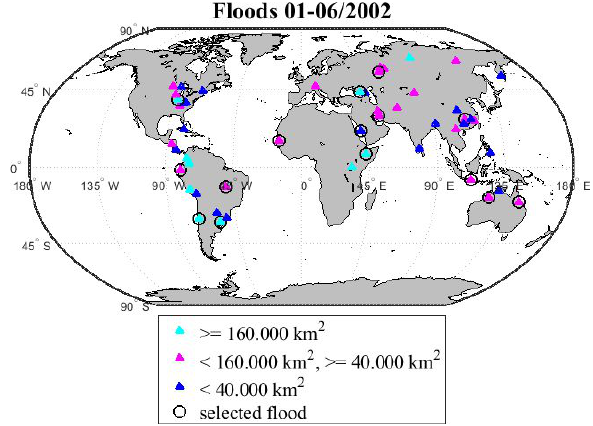
Fig. 2. Geographical locations of the floods in the time span of Jan- uary to June 2002. According to the affected area, the floods are marked in cyan for floods equal or larger than 160.000 km 2 , ma- genta for floods equal or larger than 40.000 km 2 and smaller than 160.000km 2 . Small flood (smaller than 40.000km 2 ) are marked in blue. Floods smaller than 3.000 km 2 are excluded from the graph. Floods selected for further analysis, due to a visibility of the in- dicated flood in the hydrological layer of the ESA ESM model are circled in